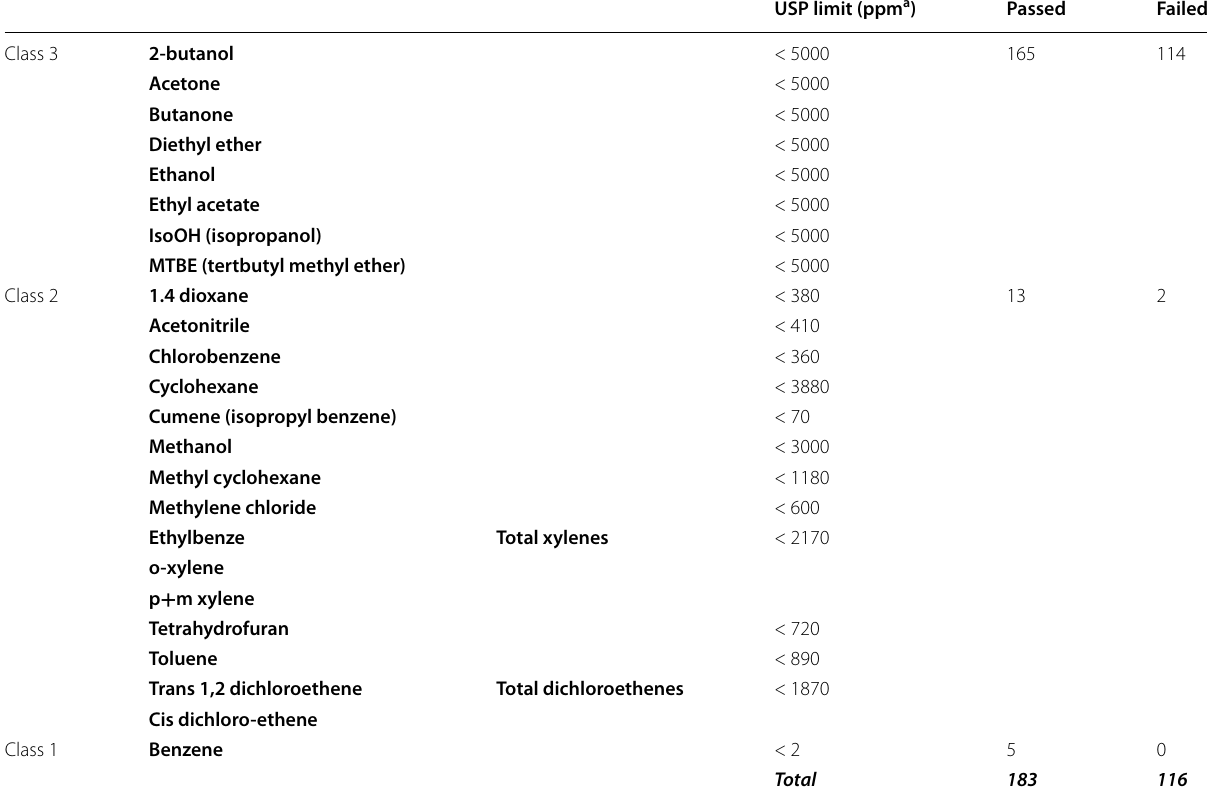
Table 5 Sample failures when solvent concentrations are